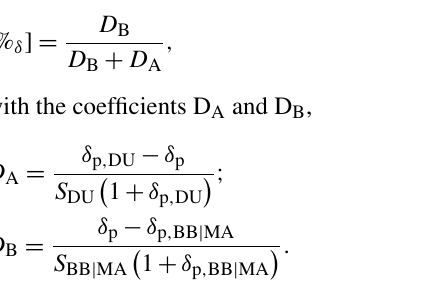
Fig. 2. MODIS is a spaceborne imaging sensor which